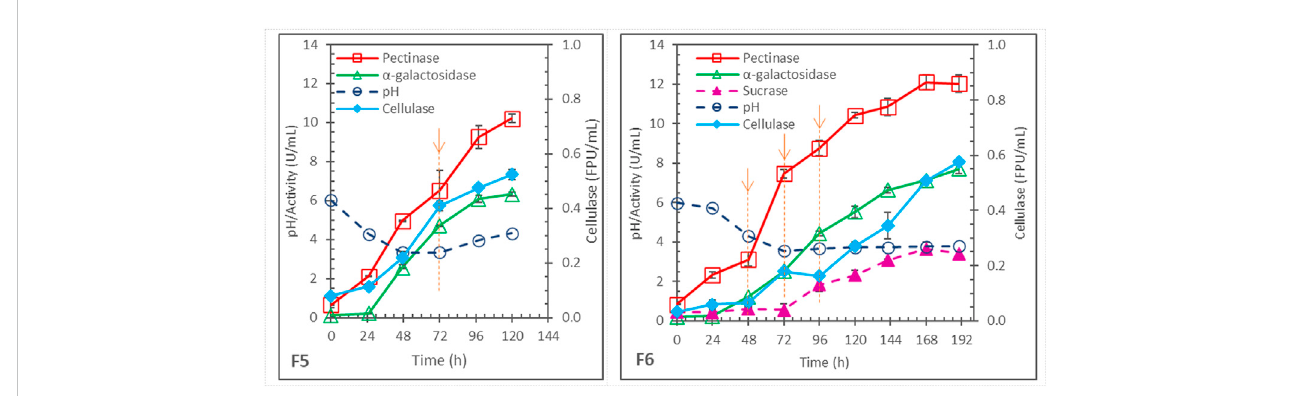
FIGURE 2 Enzyme production in pH-uncontrolled, fed-batch fermentations with same initial pH 6 and 2x N-sources but different soybean hull (SH) addition; each arrow with dashed line indicating 1x SH addition; F5 = 2x SH initially + 1x SH at 72 h, and F6 = 2x SH initially + 1x SH each at 48, 72, and 96 h.